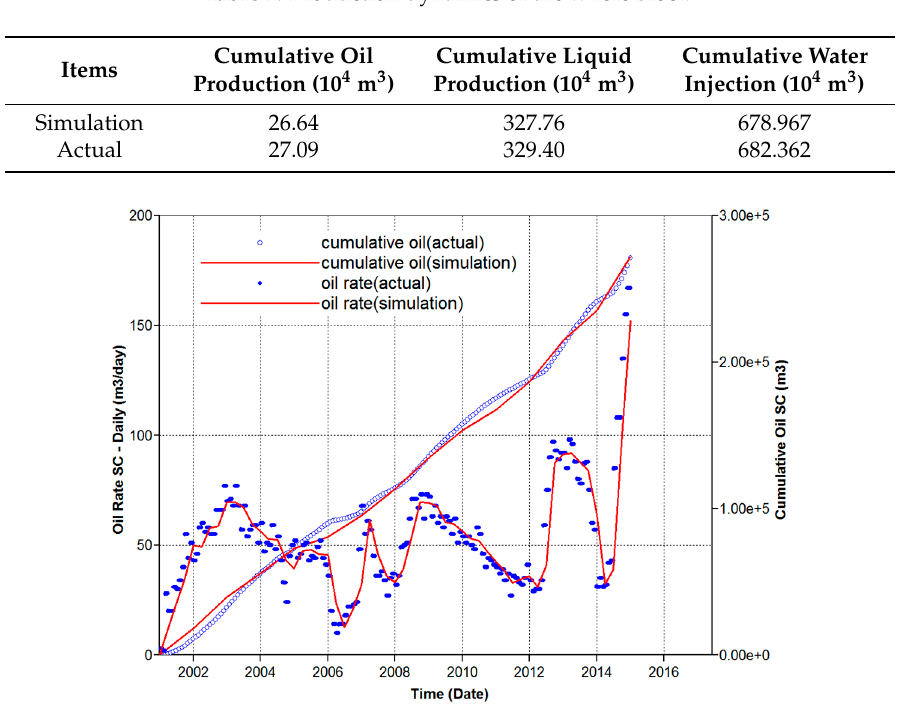
Figure 3. Fitting curve of the oil production in the experimental area.